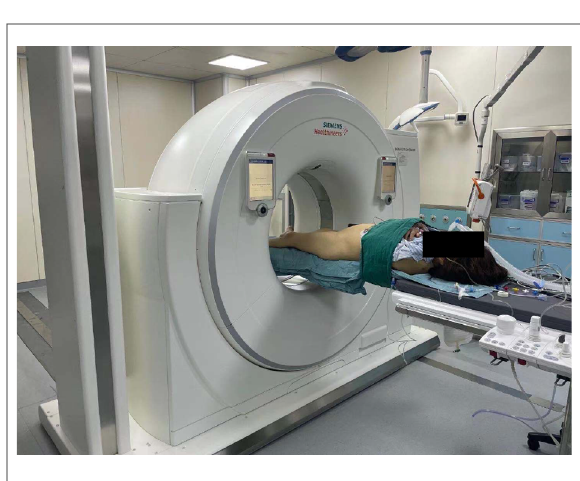
FIGURE 4 Standard posture of the patients with sacroiliac screw fi xation assisted by intraoperative